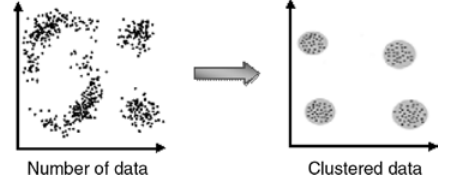
Figure 1: Basic Diagram of Data